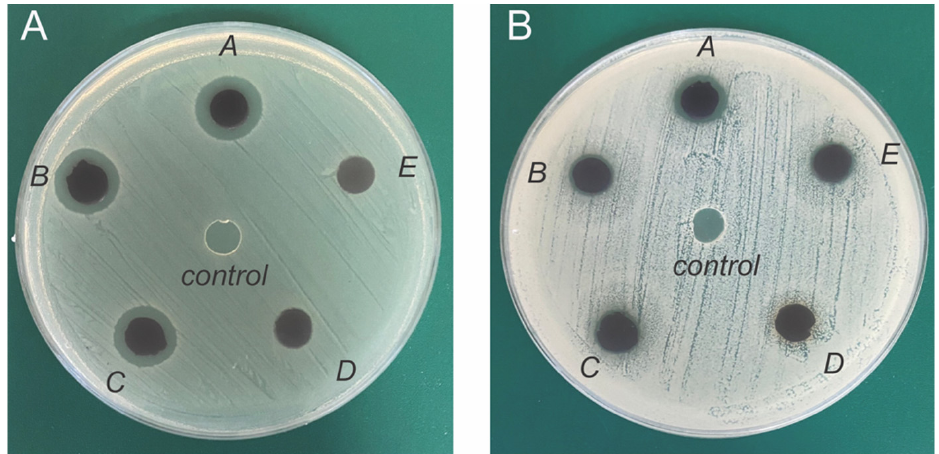
Figure 5. Disc diffusion assay of the AgNP-loaded hydrogels against ( A ) E. coli and ( B ) S. aureus . Hydrogels A, B, C, D, and E contained AgNPs at 1.0, 0.5, 0.25, 0.125, and 0.0625 mg/cm 2 , respectively. Control refers to the hydrogel without AgNPs.